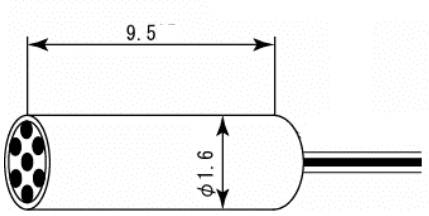
Fig. 2 The semiconductor transducer.